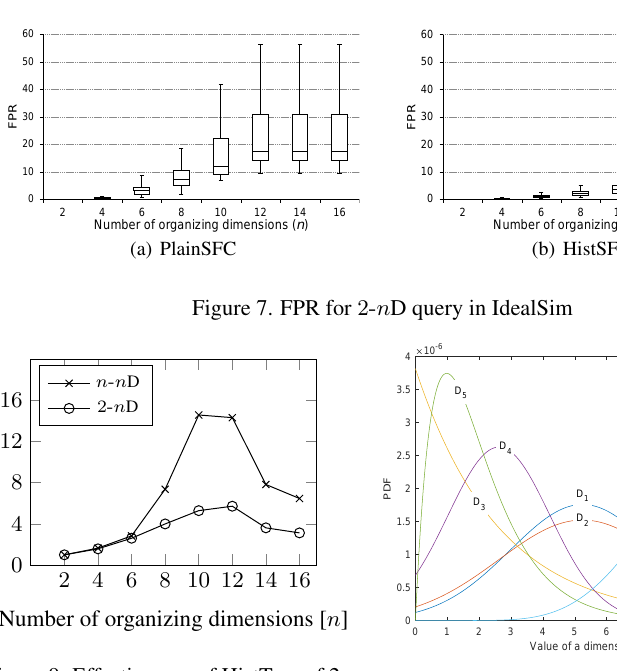
Figure 9. Effectiveness of HistTree of 2